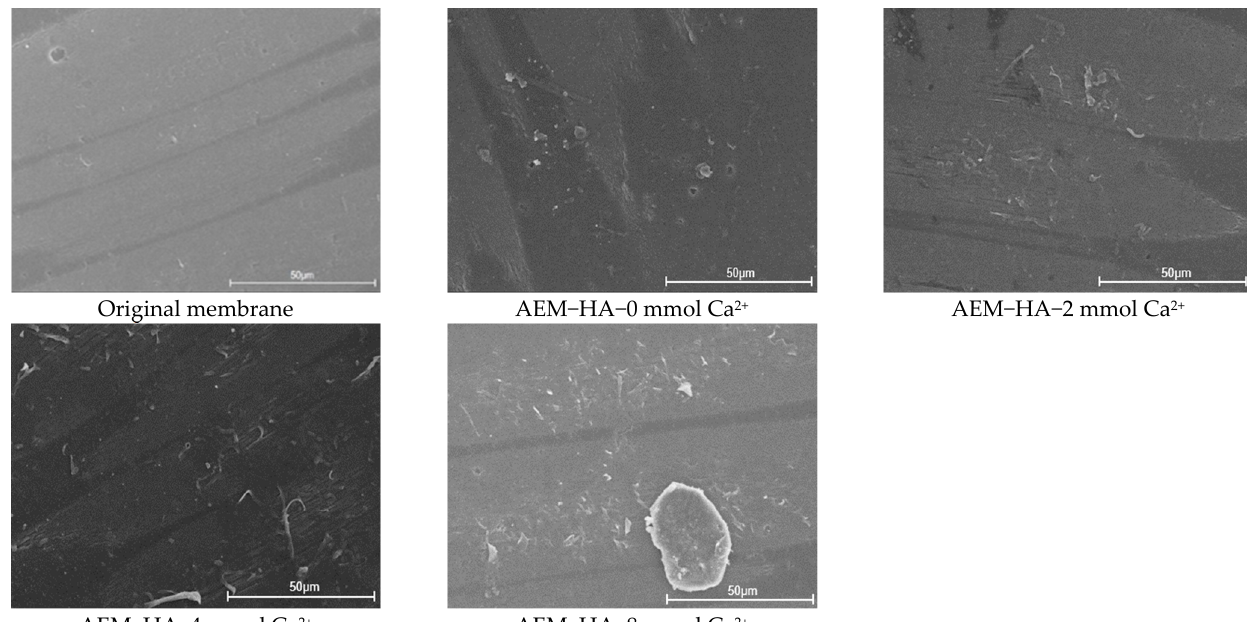
Figure 4. SEM images of original and used AEMs in AEM-HA system with different calcium ion concentration.